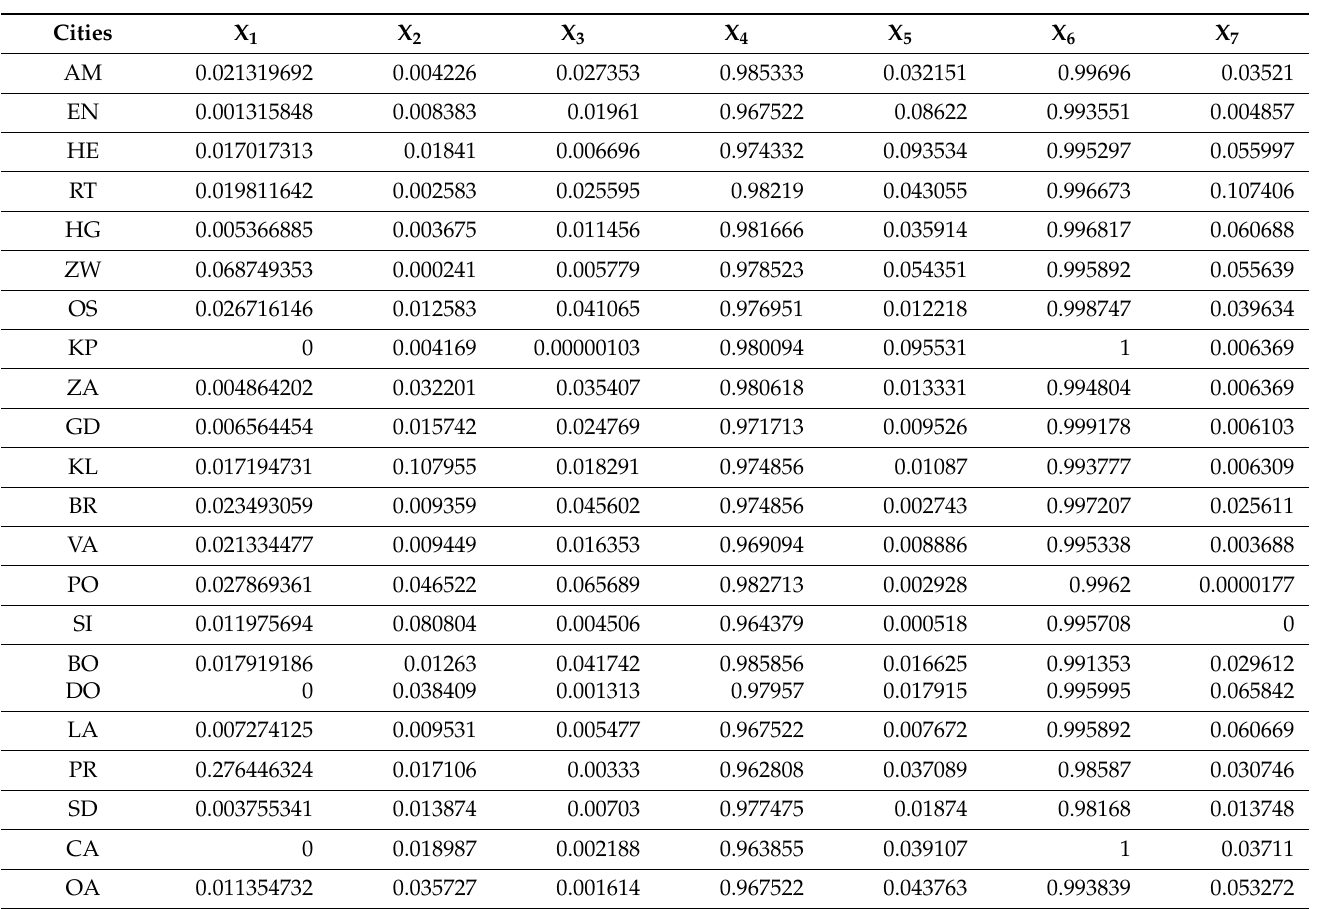
Table A3. Normalized decision